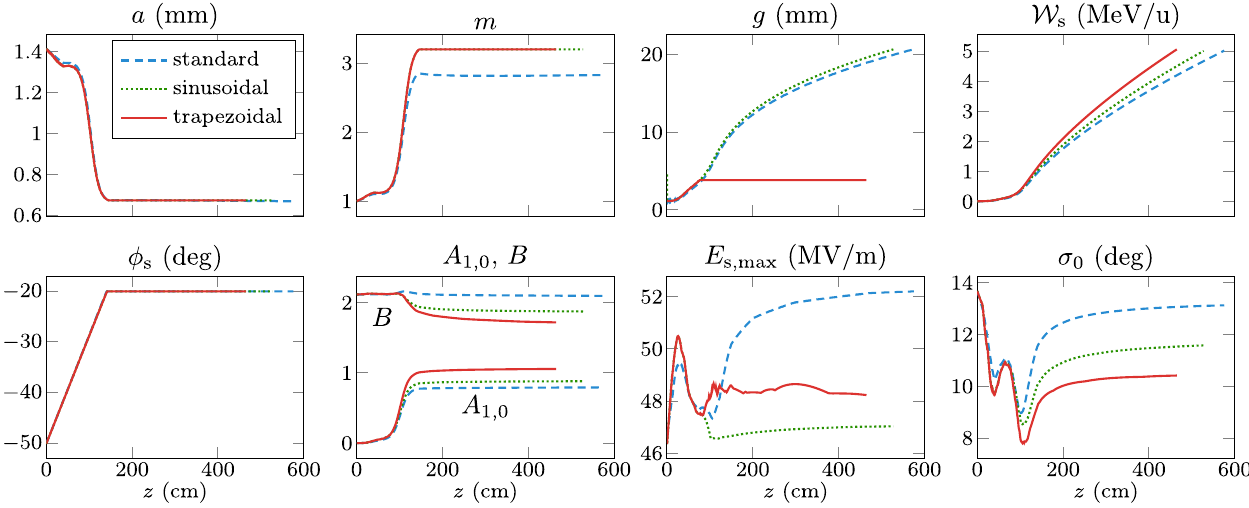
FIG. 13. Comparison between standard-vane RFQ, trapezoidal-vane RFQ, and a design employing purely sinusoidal vanes, for the same final energy of 5 MeV/u. Parameters are shown as functions of the position z , while V 0 , r 0 , and ϱ are constant and equal in all designs. The gap length g is a free parameter for the trapezoidal design, but equals the cell length in the other